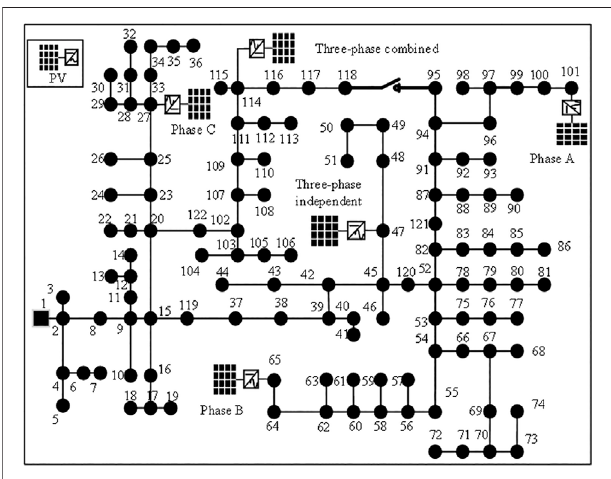
FIGURE 2 | Diagram of the modi fi ed IEEE 123 nodes test feeder.